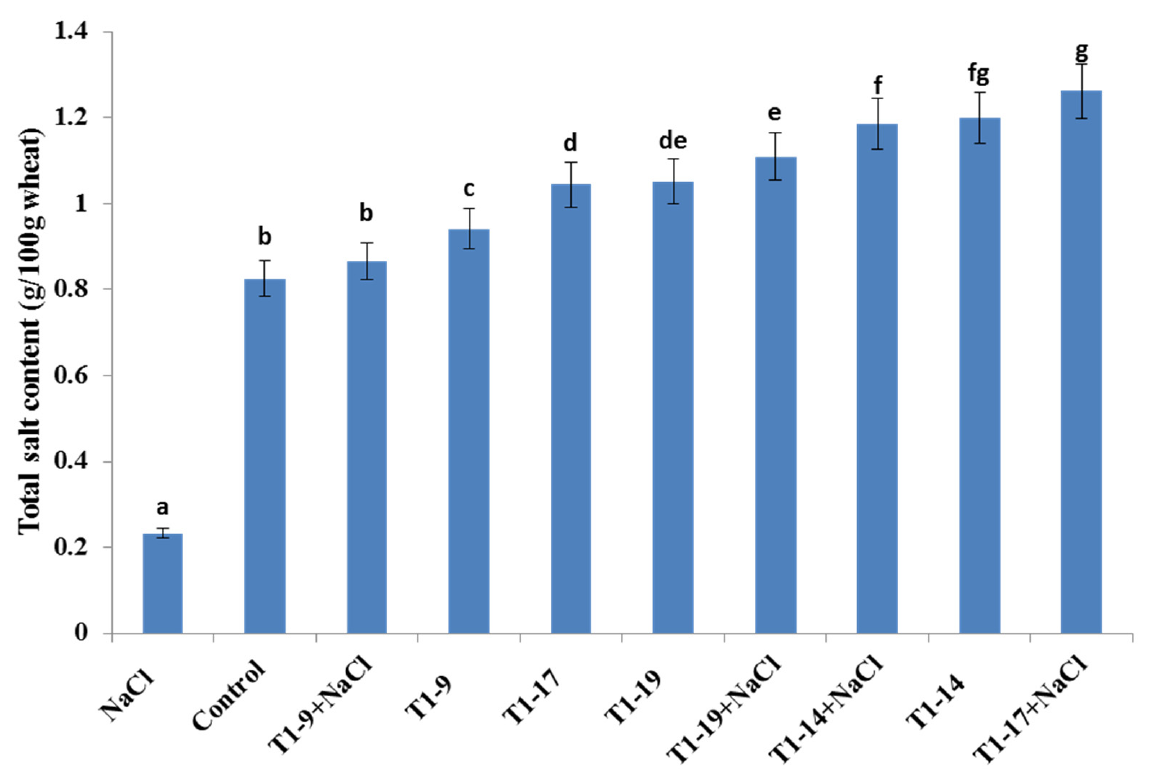
Figure 4. Effect of seed biopriming with PGPB strains on the total salt content (g 100 g − 1 wheat) of durum wheat plants under different salinity regimes. Bars represent the standard error of the mean (SEM). Different letters above the error bars indicate a significant difference at p < 0.05. Control, no NaCl and no PGPB; NaCl, no PGPB in salinized soil; T1, bioprimed seed; 9, Bacillus pumilus MA9; 14, Virgibacillus halodenitrificans MA14; 17, Bacillus subtilis MA17; 19, Bacillus safensis MA19.